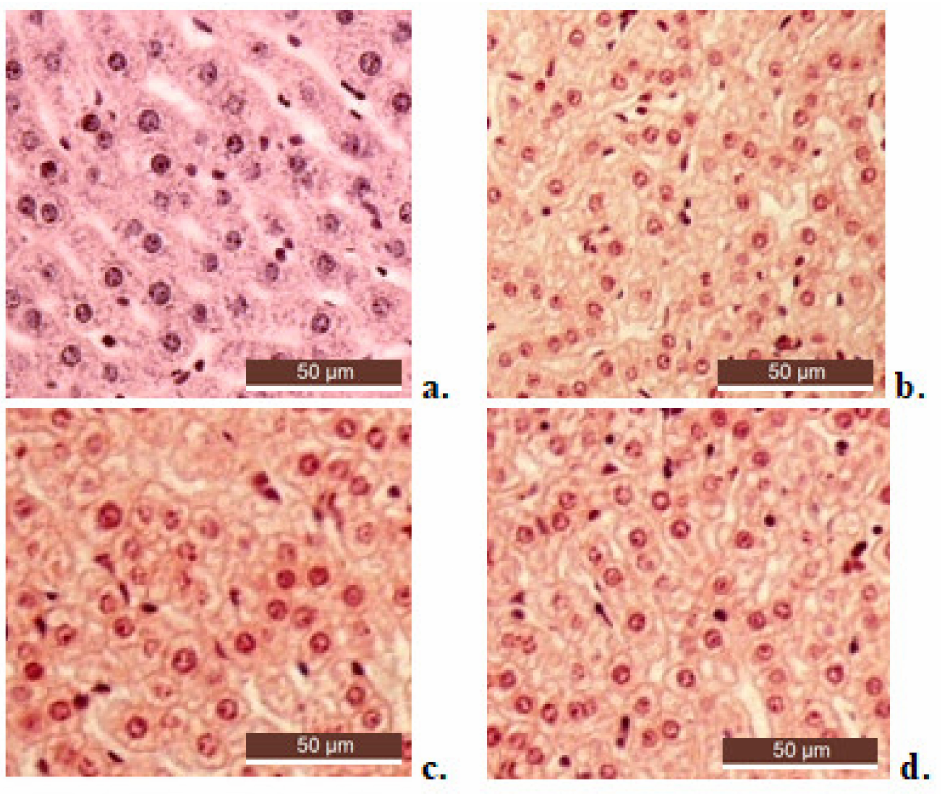
Figure 7. Histological liver architecture in animals treated with deionized water ( a ), Zn ( b ), LV-Zn ( c ), and LVC-Zn ( d ); H&E stain ×